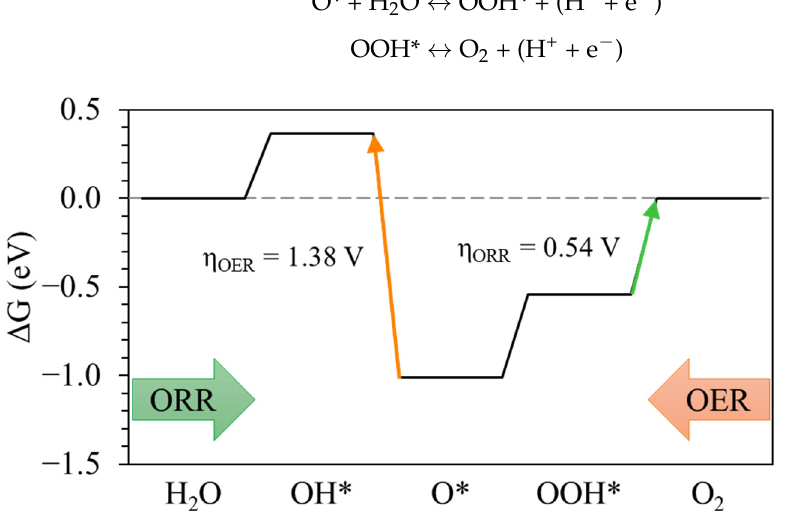
Figure 2. OER/ORR Gibbs free energy diagram of Pt(111) catalyst at equilibrium potential (U = 1.23 V) under acidic conditions (pH = 0 and T = 298 K) An asterisk (*) denotes the adsorption state.